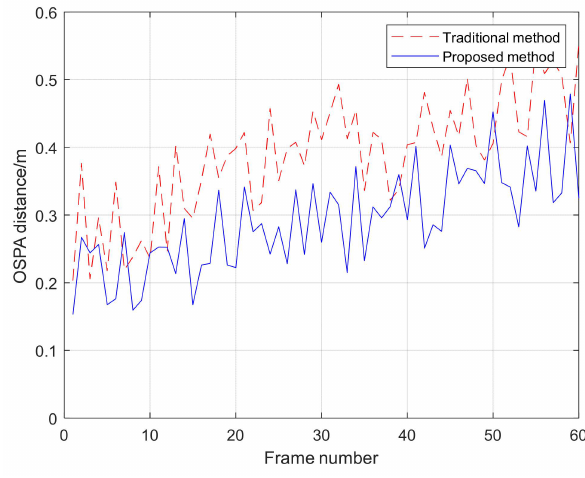
Figure 11. OSPA distance of traditional method and proposed